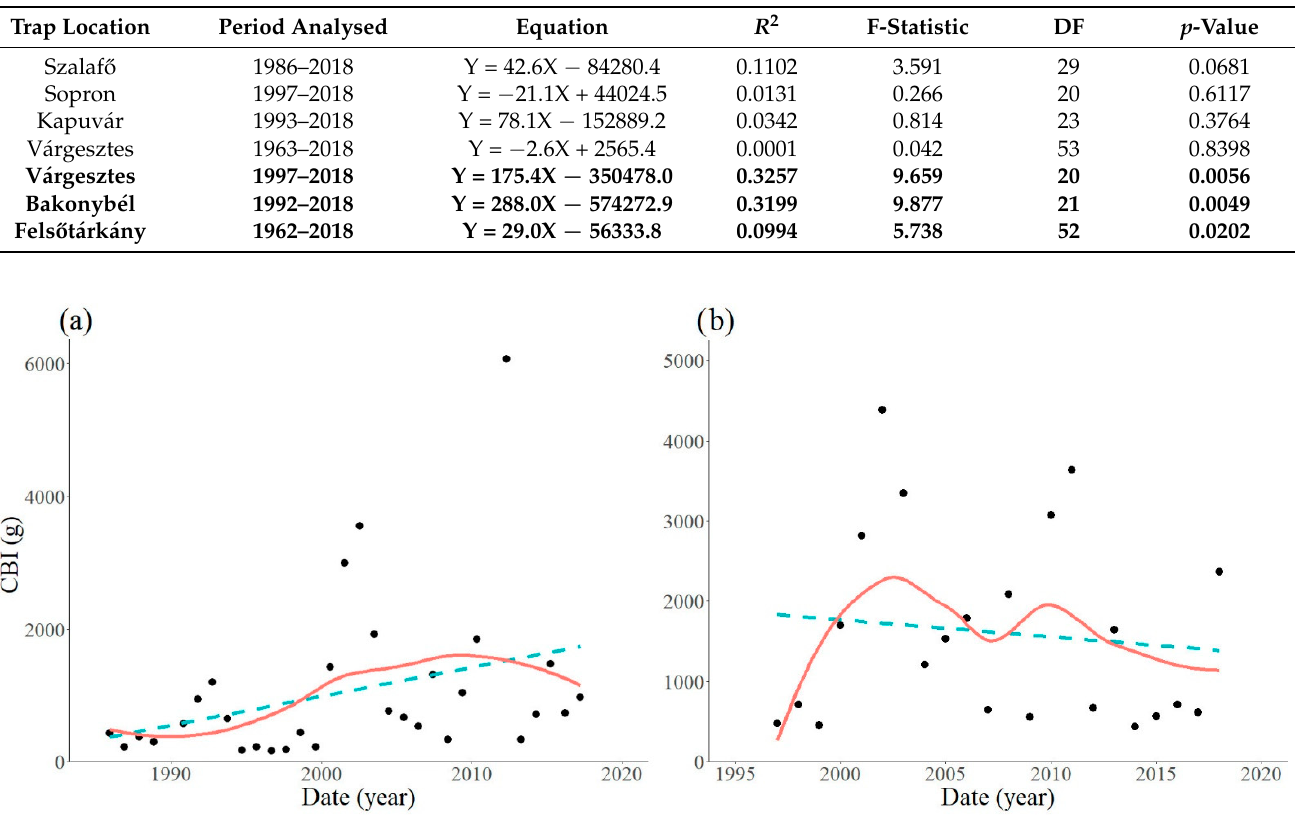
Table 2. Results of the trend analyses for six trap locations and analysis for different time windows in case of Várgesztes. Significant trends are given in bold.